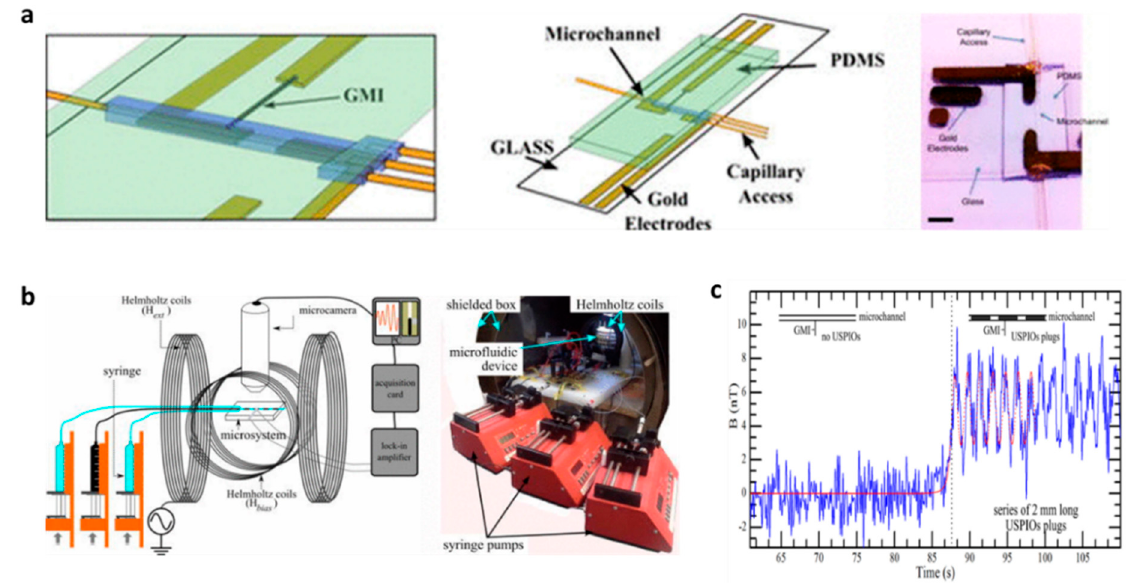
Figure 10. ( a ) Left to right: 3D schematics of the microfluidic system showing the PDMS micro- channel on one side of the glass substrate, the GMI microwire with electrical connections on the other side, and a picture of the actual device. ( b ) Picture of the experimental bench where one can see the programmable syringe pumps, the shielded box, the Helmholtz coils, and the microfluidic system. ( c ) Measured magnetic signal before and after (black dotted, t = 87.5 s) injection of the US- PIOs plugs with 5.47 × 10 − 9 mol contents (2 mm long-20 nL volume with a molar concentration of 230 mmol/L). Reprinted with permission from Ref. [67]. Copyright 2022 AIP Publishing. Feng et al. employed a GMI-based immunoreaction platform to detect the stray mag- netic field and variation of magnetic signal from immunomagnetic beads [90]. In this con- figuration, a meander-line structured Co-based ribbon was integrated onto a microfluidic chip fabricated by MEMS. The integrated microfluidic chip consisted of incoming inlets and incubation and reactive chambers used as the biomarker detection system. In this detection scheme, prostate specific antigen (PSA) was detected at a concentration of 0.1 ng/mL, which is quite promising for further quantitative analysis. Recently, Melnikov et al. fabricated FeNiCu multilayer nanostructures that were used for the detection of mag- netic particles in a blood-vessel-like structure [28]. The measurement of stray fields gen- erated by iron-oxide microparticles under an external magnetic field was carried out using the longitudinal MI effect. The position of magnetic composite samples mimicking a thrombus (blood clot) was performed experimentally and modelled theoretically using COMSOL. This experiment is promising for thrombosis evaluation and therapy [28]. 4.4. Real-Time Healthcare Monitoring of Patients with Respiratory Illness or COVID-19 Breathing is vital to life. Therefore, the real-time monitoring of a patient’s breathing pattern is crucial to the support of respiratory rehabilitation therapies, such as magnetic resonance exams for respiratory-triggered imaging, chronic pulmonary disease treatment, and synchronized functional electrical stimulation. While several respiratory monitoring devices have already been developed [91–96], they are often in direct contact with a pa- tient, which increases the chance of inaccurate or limited data. In this context, Thiabgoh et al. [94,96] developed a novel, noninvasive, and contactless magnetic sensing platform